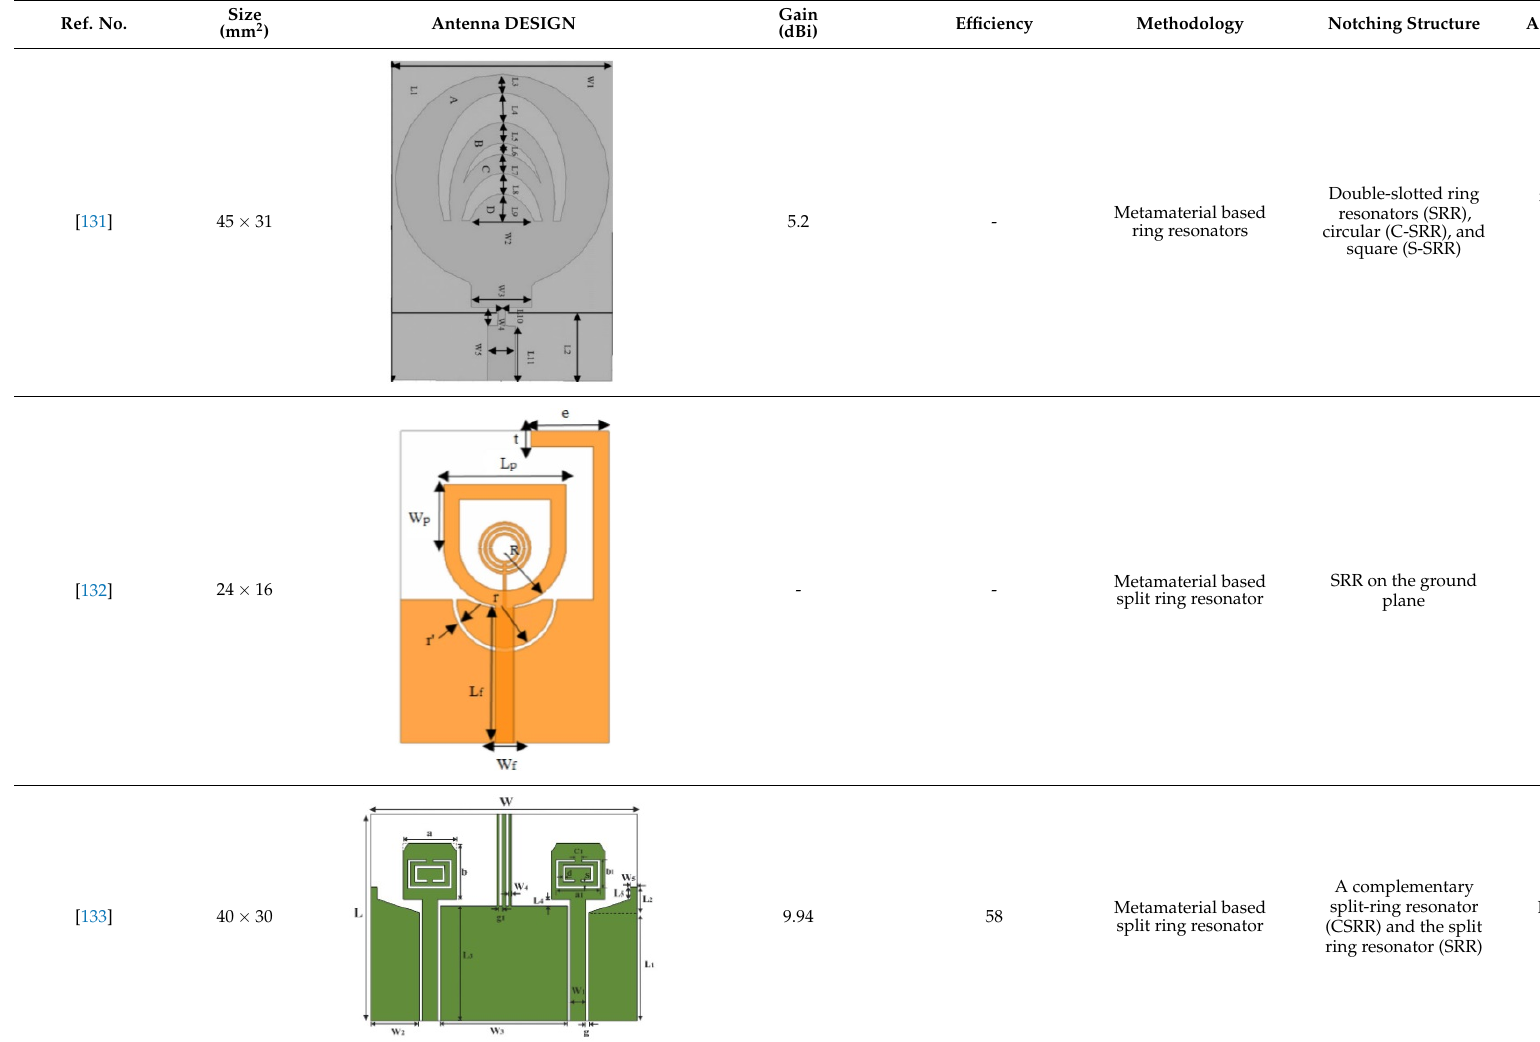
(CSRR) and the split ring resonator (SRR)